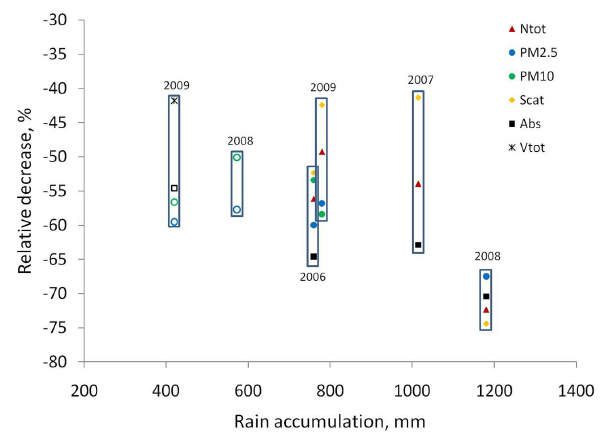
Fig. 3. The relative change of the aerosol concentrations from the pre-monsoon to monsoon season as a function of the June– September rain accumulation. Solid symbols: data from Muktesh- war; open symbols: data from Gual Pahari. Each year is surrounded by a